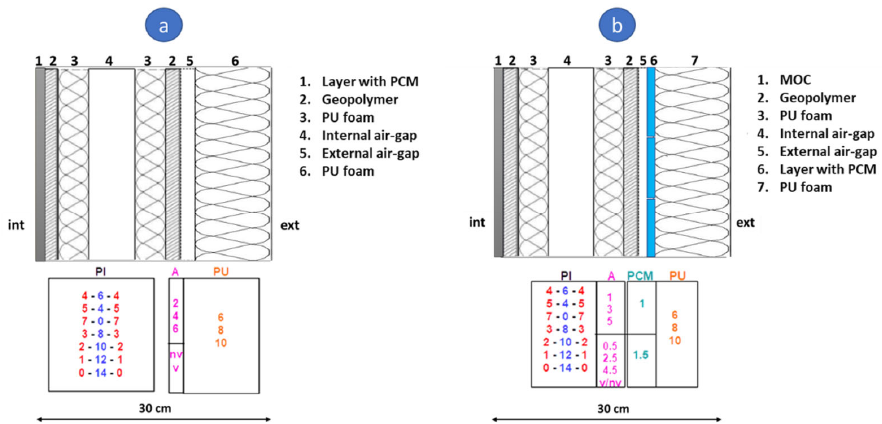
Figure 2. Scheme of simulated configurations: ( a ) PCM on the internal side; ( b ) PCM on the external side.